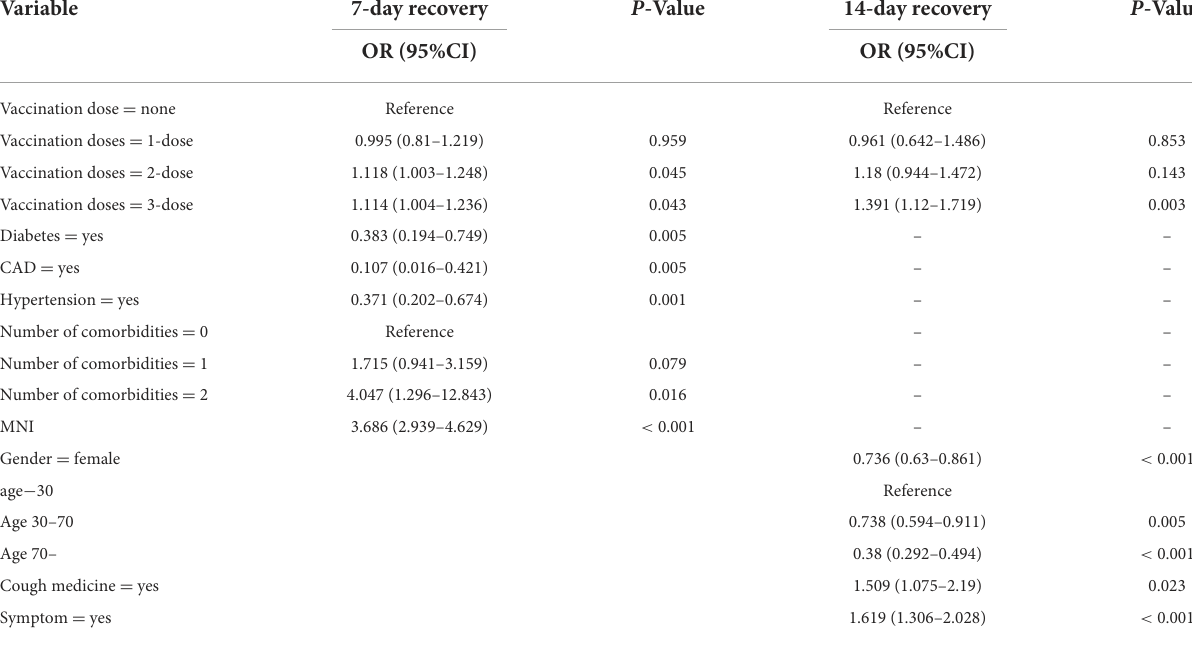
TABLE 2 Multivariable logistic regression models for Omicron infection